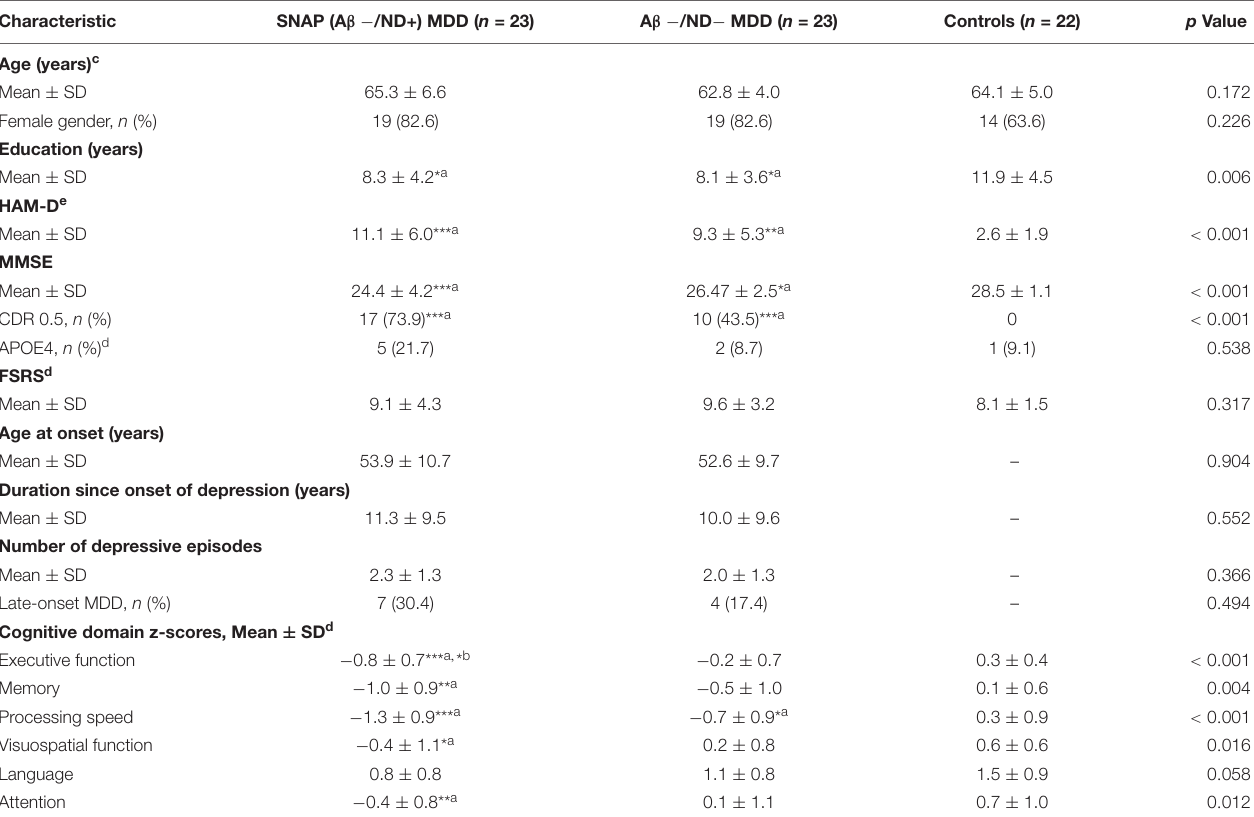
TABLE 1 | Demographic and clinical characteristics of the SNAP MDD patients, A β − /ND − MDD patients, and control subjects.